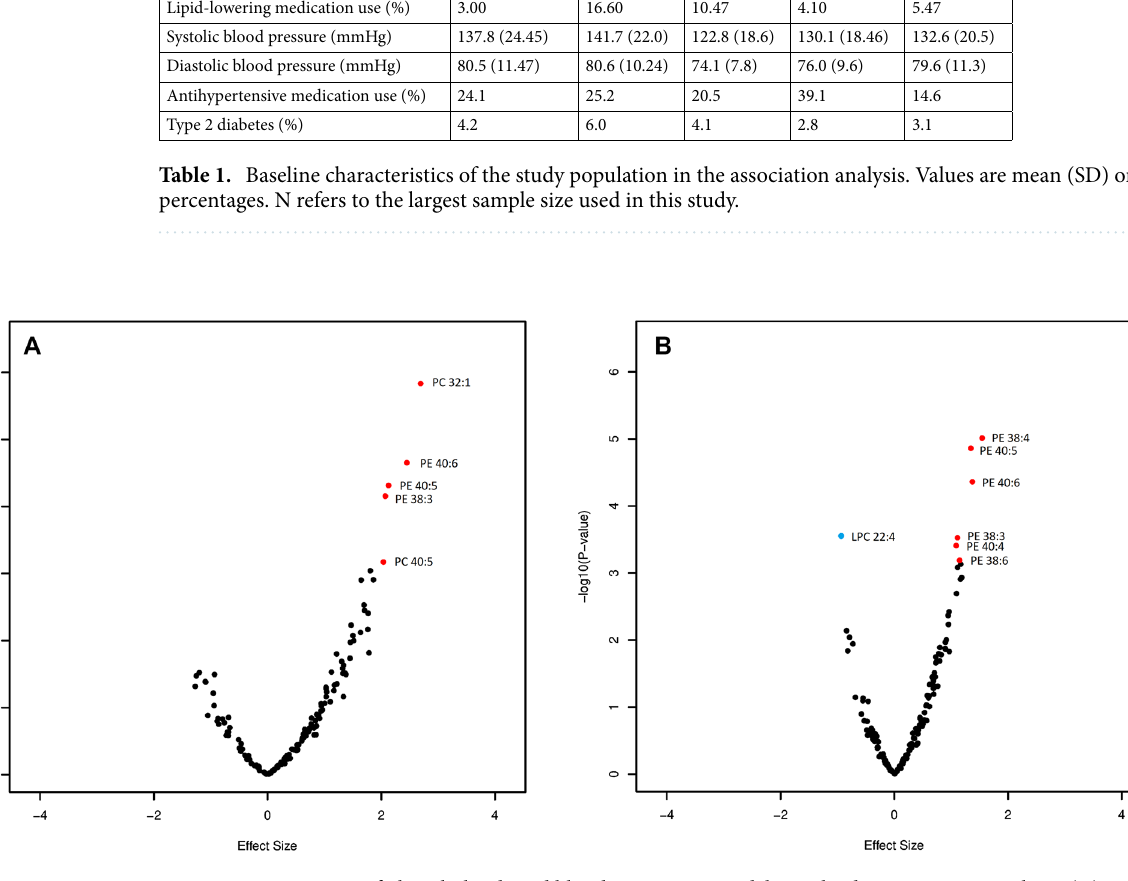
Figure 2. Association of phospholipids and blood pressure in model 1 in the discovery meta-analysis. ( A ): phospholipids associated with SBP. ( B ) phospholipids associated with DBP. Age, sex and family relationship were adjusted for in the regression analysis. Red: Lipids are significantly associated with blood pressure and replicated. Blue: lipid LPC 22:4 significantly associated with blood pressure but failed in the